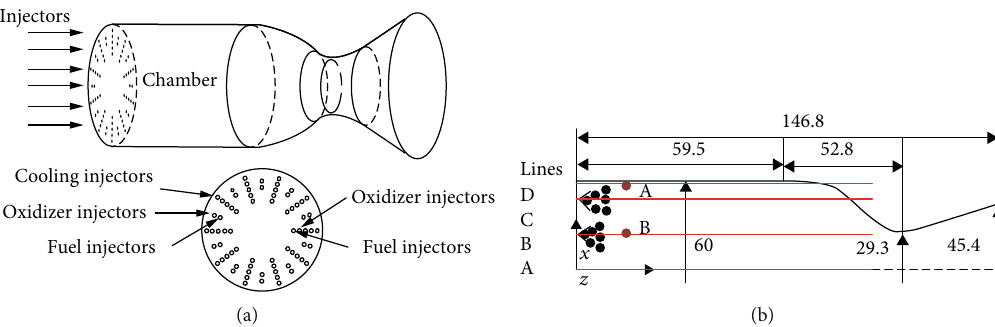
Figure 1: The schematic diagram and con fi guration parameters of the combustor and the injectors. (a) The schematic diagram of the combustor and the injectors. (b) The con fi guration parameters of the combustor (unit: